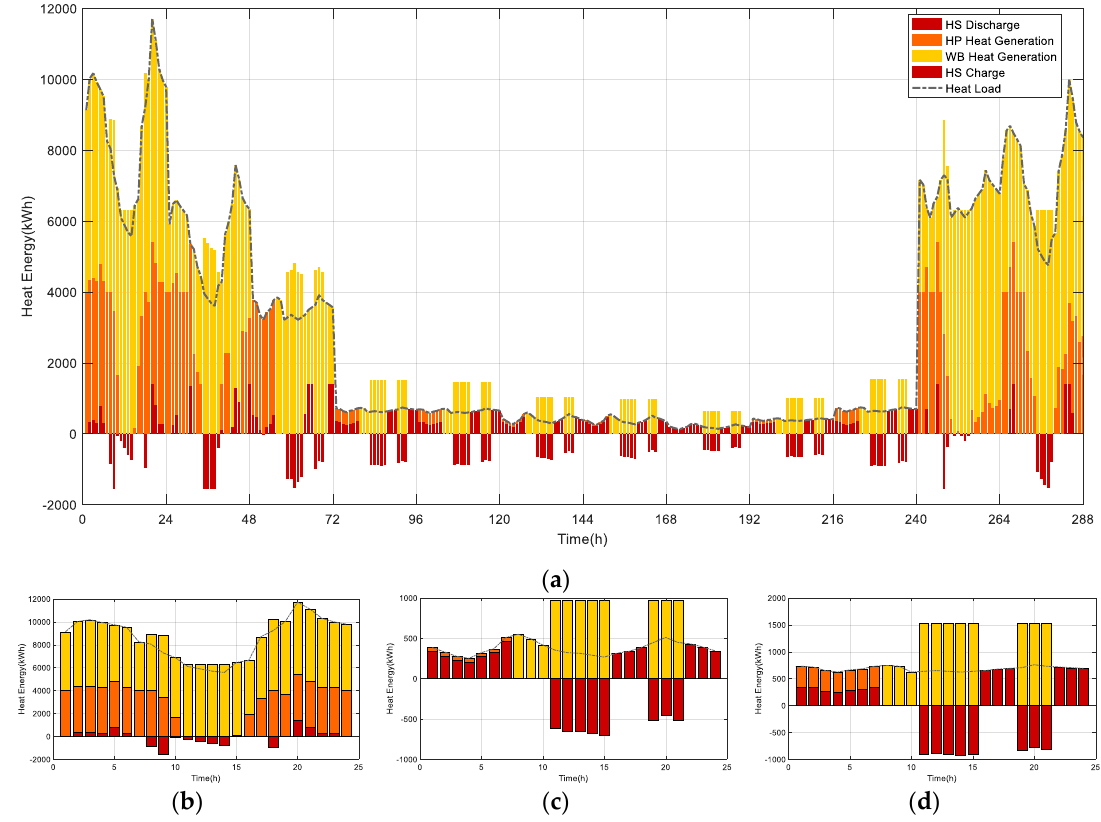
Figure 14. Daily running of heat-conserving device: ( a ) days of running heat-conservation device output; ( b ) January; ( c ) July; ( d ) October.